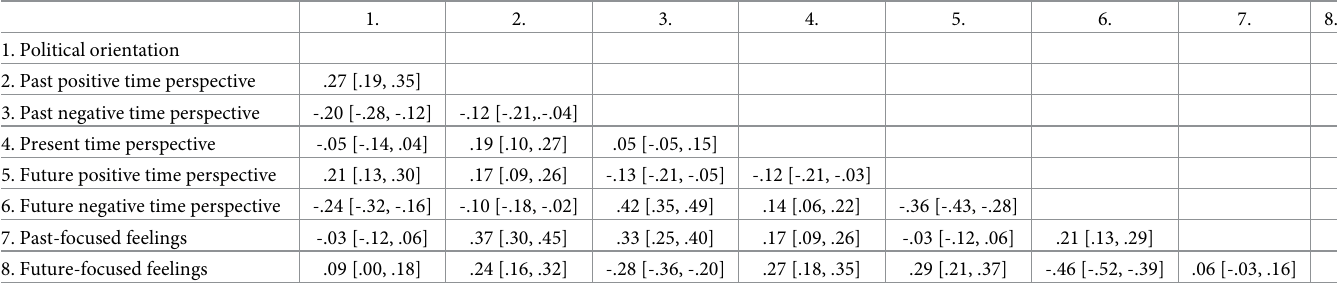
Table 3. Associations between political orientation and the dimensions of time